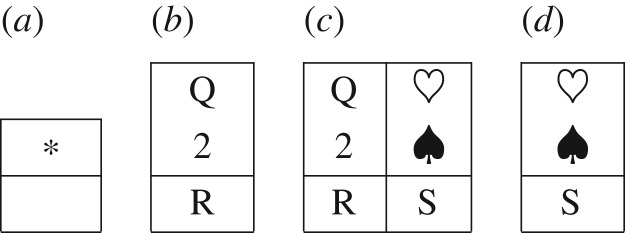
Relational tables for the presheaf FQ2.